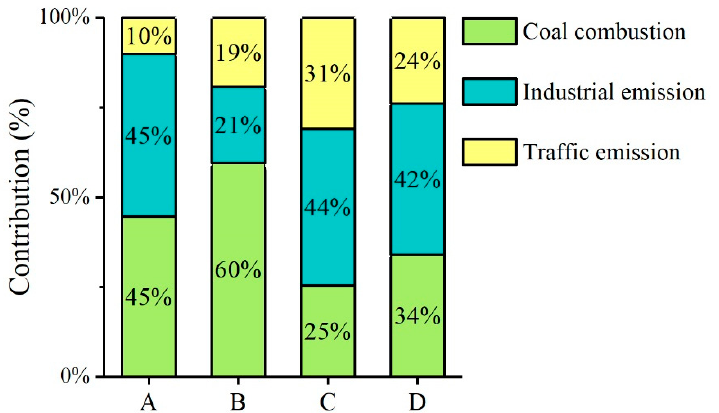
Figure 4. Contribution of PM 2.5 heavy metals from different source. Note: ( A ) represents non-heating period of Huagong Hospital in 2015; ( B ) represents heating period of Huagong Hospital in 2015; ( C ) represents non-heating period of Xinqu Park in 2015; ( D ) represents heating period of Xinqu Park in 2015.